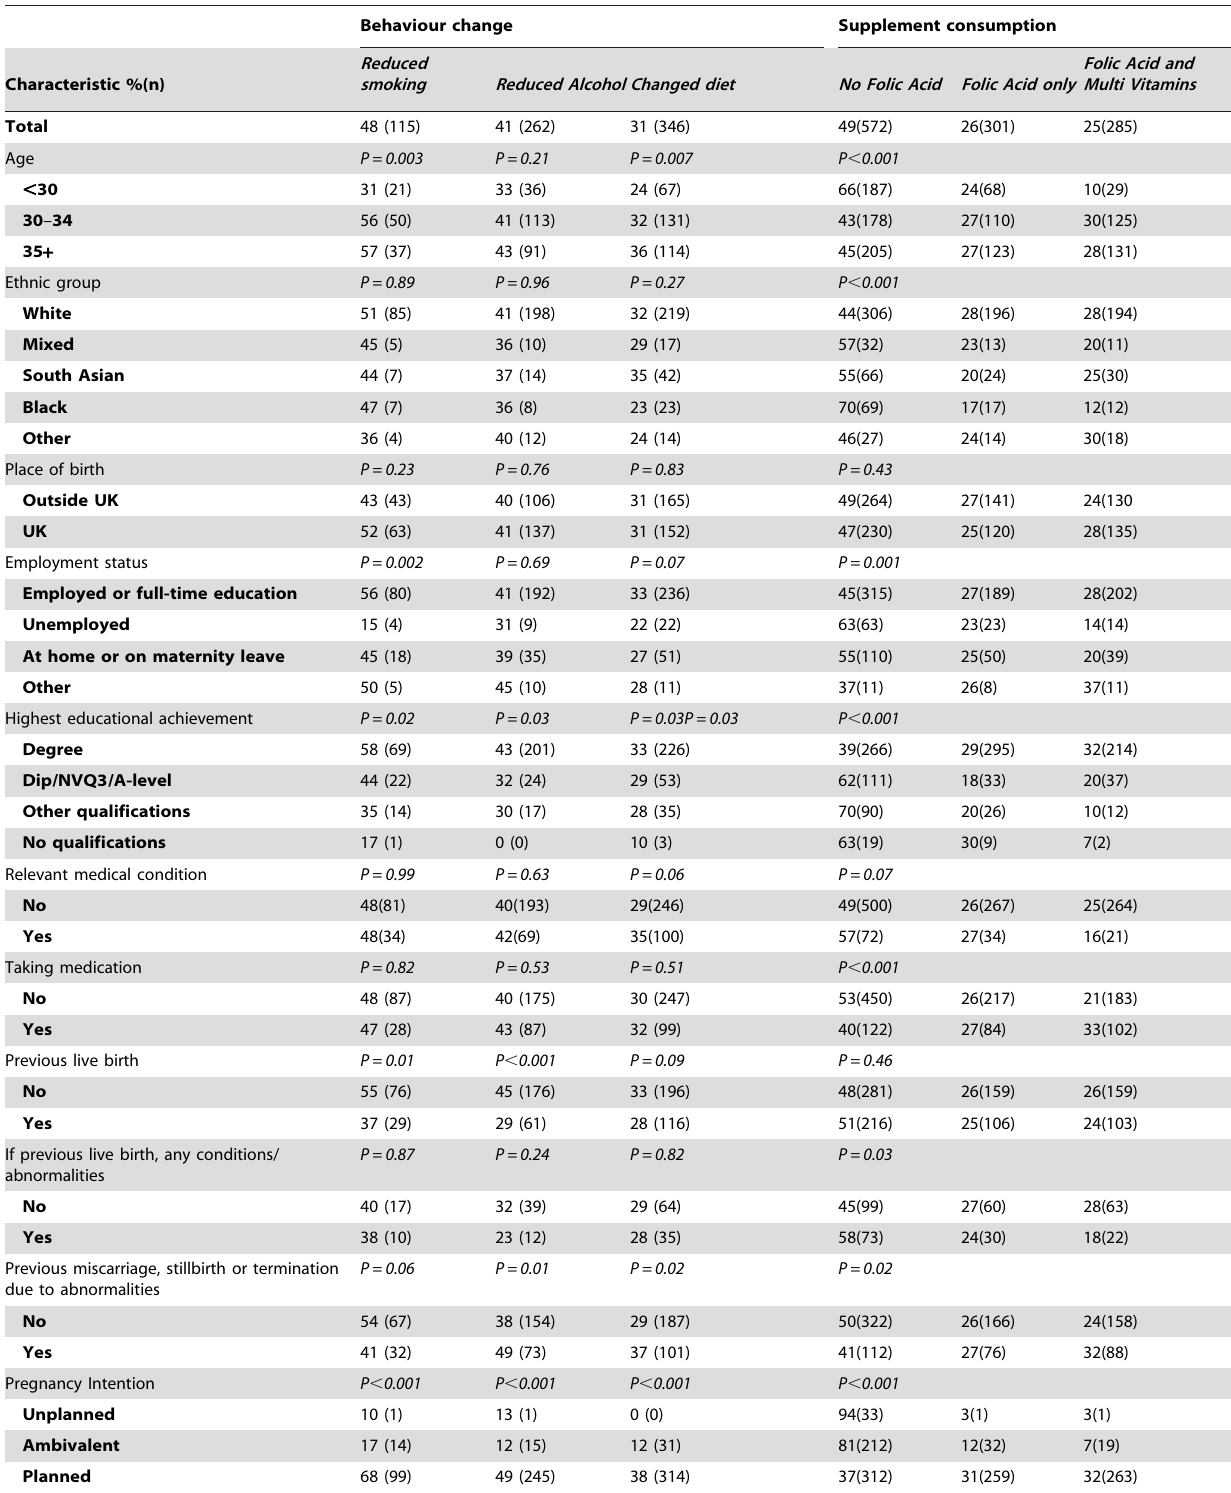
Table 2. Health behaviour change and supplement consumption before